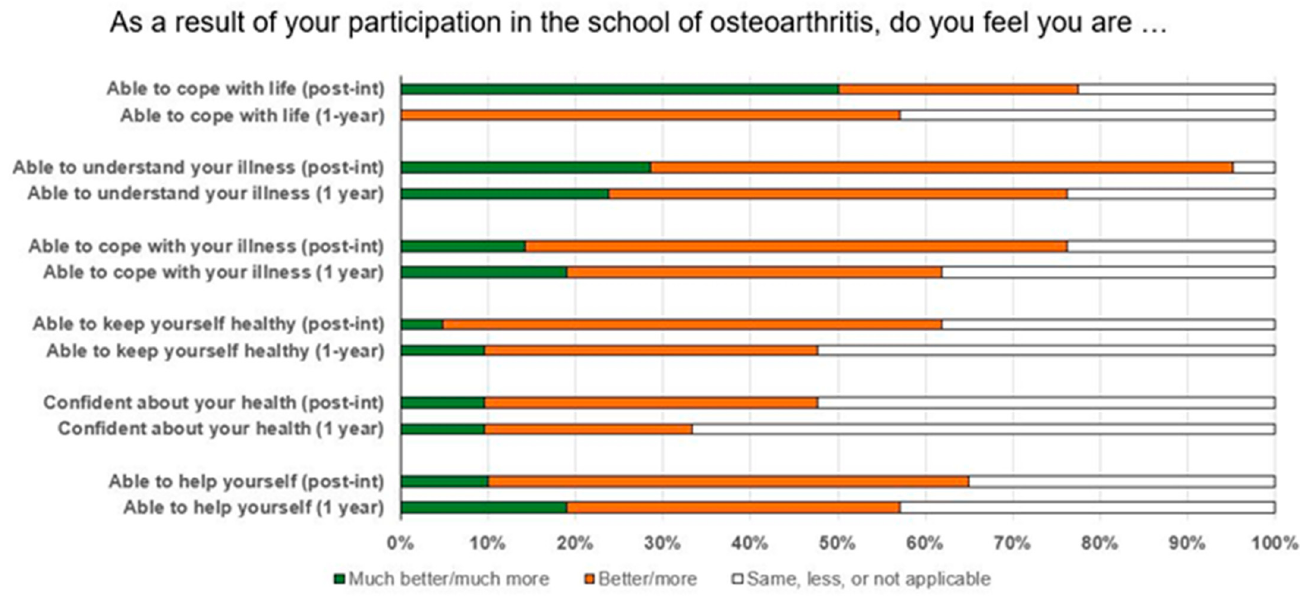
Figure 3. Patient enablement instrument (PEI) pooled data of all participants at the post-intervention and 1-year post-intervention